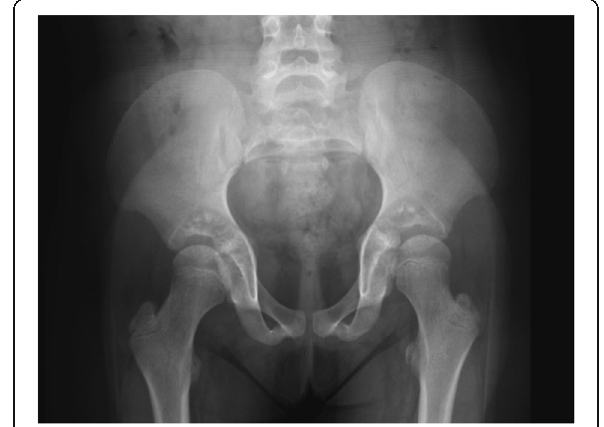
Fig. 15 Plain radiograph of the pelvis in a 7-year-old Down syndrome girl, showing the typical “ Mickey Mouse ”